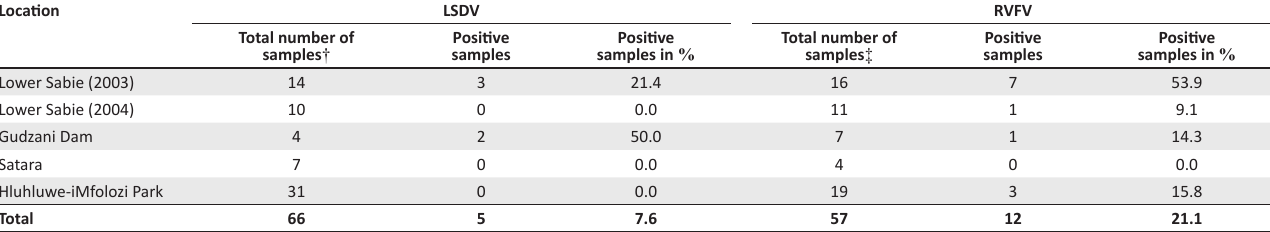
TABLE 3: Serum virus neutralisation test results for lumpy skin disease virus and Rift Valley fever